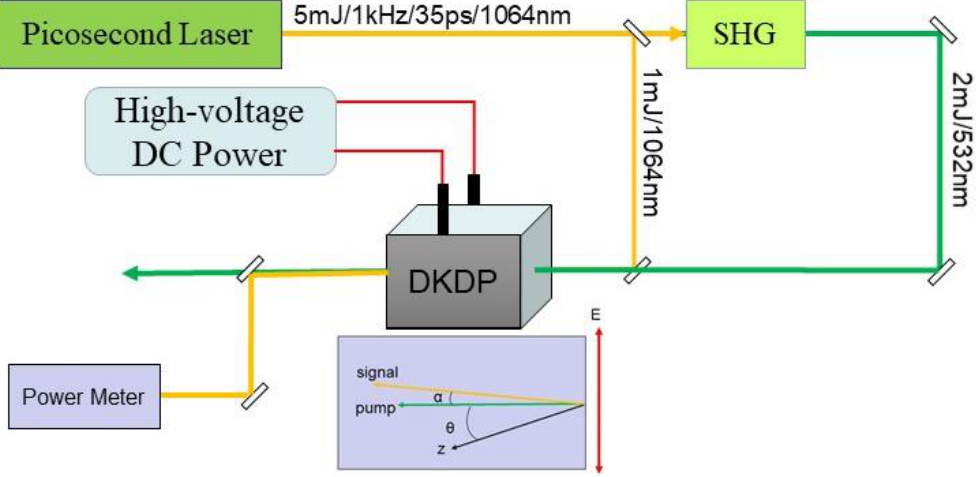
Figure 4. Phase compensation experimental setup. SHG: LBO crystal with the size of 4 mm × 4 mm × 15 mm; yellow line represents pulses at 1064 nm; green line represents pulses at 532 nm.